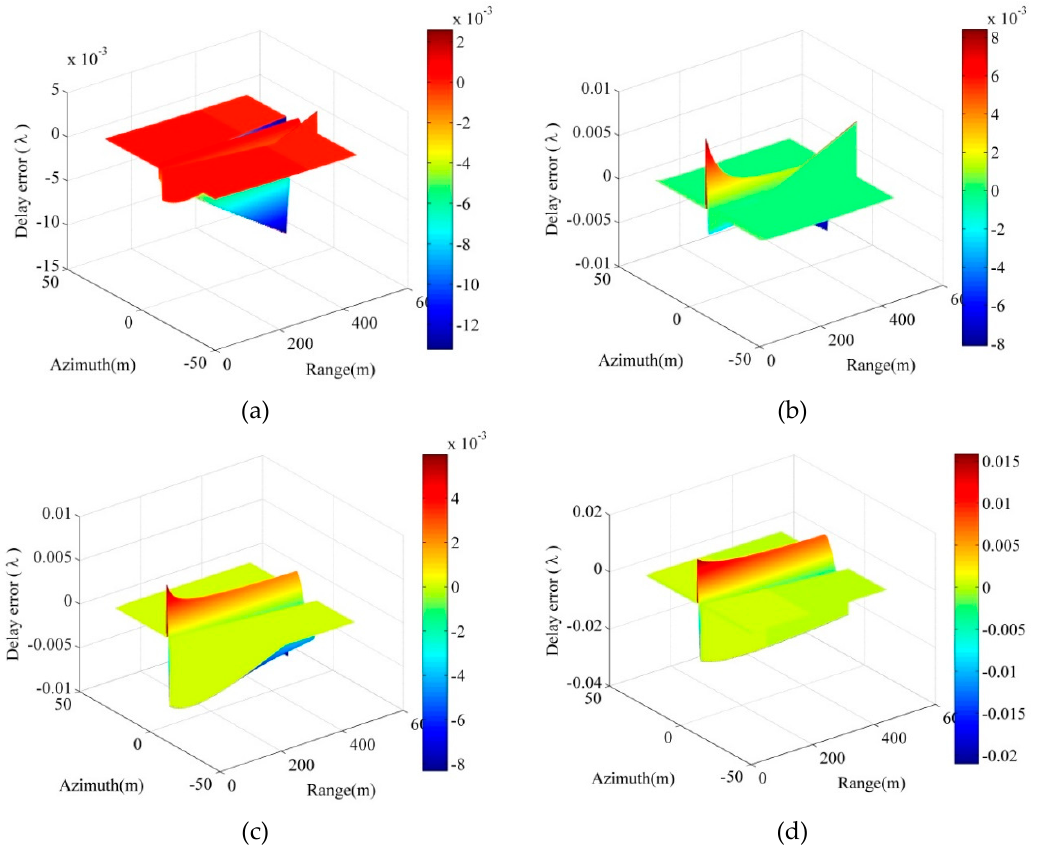
Figure 4. Delay errors. ( a ) 2° yaw angle and 0° pitch angle; ( b ) 0° yaw angle and 2° pitch angle; ( c ) 2° yaw angle and 2° pitch angle; ( b ) 3° yaw angle and 3° pitch angle.